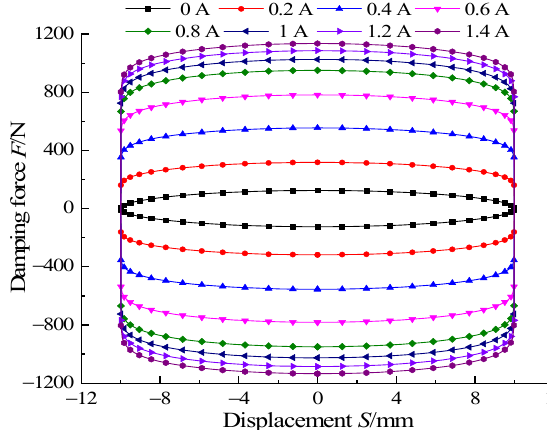
Figure 15. Damping force versus displacement at different currents. To study the influence of different vibration excitations on the output damping force of the damper, keeping the current constant at 1 A, sinusoidal excitations of different frequencies and amplitudes for the piston head, and the dynamic simulation results are shown in Figure 16. Figure 16a is the relationship curve of output damping force with displacement at different frequencies when the amplitude is 10 mm. Figure 16b is the relationship curve of output damping force with displacement under different amplitudes when the frequency is 1 Hz. At the same amplitude, the output damping force increased slightly with an increase in the frequency; and at constant frequency, the output damping force increased slightly with an increase in amplitude. The main reason is that when a certain excitation current was given, the proposed damper has both viscous and magnetically induced damping forces under the action of the magnetic field. The magnetically induced damping force is only related to the excitation current, and the current does not change, therefore, the magnetically induced damping force is constant. The viscosity-induced damping force is related to the flow velocity of the MR fluid; the faster the velocity, the greater the viscous damping force. As the excitation frequency and amplitude of the piston head increase, the flow velocity of the MR fluid in the damper will increase, increasing the viscosity-induced damping force, and the viscosity-induced damping force accounts for a smaller proportion of the total damping force. Therefore, the output damping force of the damper will increase slightly with frequency and amplitude.